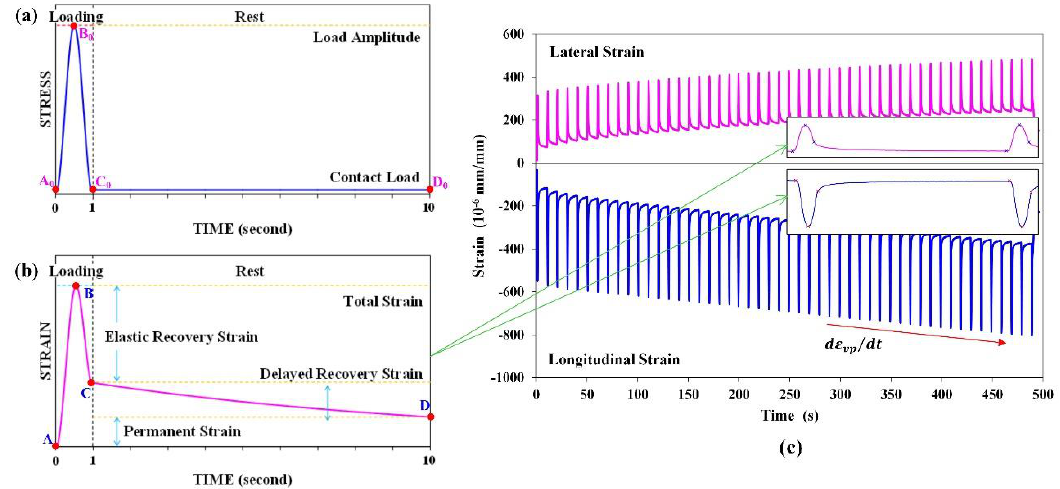
Figure 4. ( a ) Loading curve and ( b ) corresponding strain curve in the loading/rest combination of 1 s/9 s in RLPD tests, and ( c ) an illustration of the longitudinal and lateral permanent strain rate. The total strain was divided into three parts of instantaneous recoverable strain, delayed recoverable strain, and residual strain to characterize the elastic, viscoelastic, and viscoplastic behaviors, respectively, of the HMA with different VA fillers and asphalt binders. The axial and lateral strain in 50 cycles of the loading/rest (1 s/9 s) process at 50 °C is shown in Figure 4c. With MATLAB code, for each loading/rest cycle, the starting point A n , strain magnitude point B n , starting point of rest C n , and ending point of rest period D n , which was also the starting point of next loading/rest cycle A n +1 , were obtained to analyze the different strains with Equations (10)–(14). The rate of permanent strain (RPS) was used to characterize the resistance of permanent deformation of the materials since the developing trend of the strain curve in each loading/rest cycle was determined by residual strain.